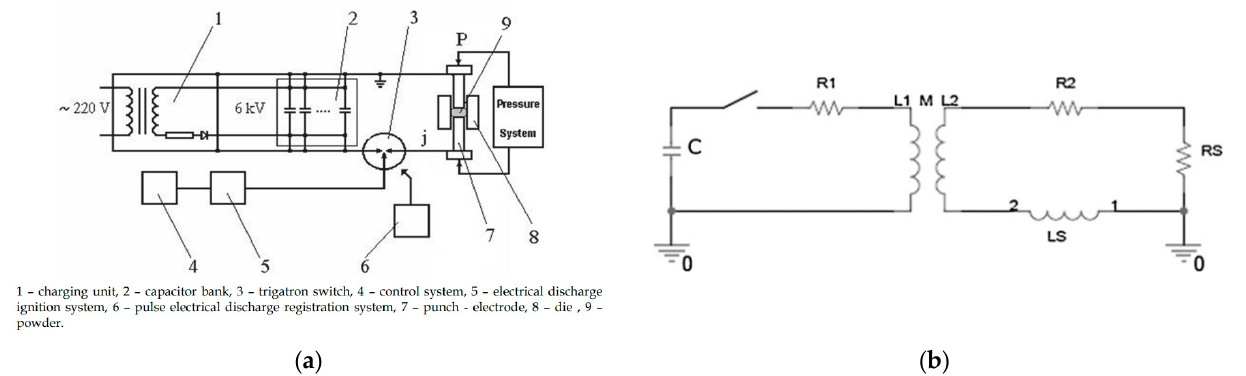
Figure 6. Configurations of the equipment used for EDC experiments: ( a ) direct discharge, reprinted from ref. [90]; ( b ) configuration for discharging after the use of a current transformer, reprinted with permission from ref. [43] Copyright 2010 Elsevier.